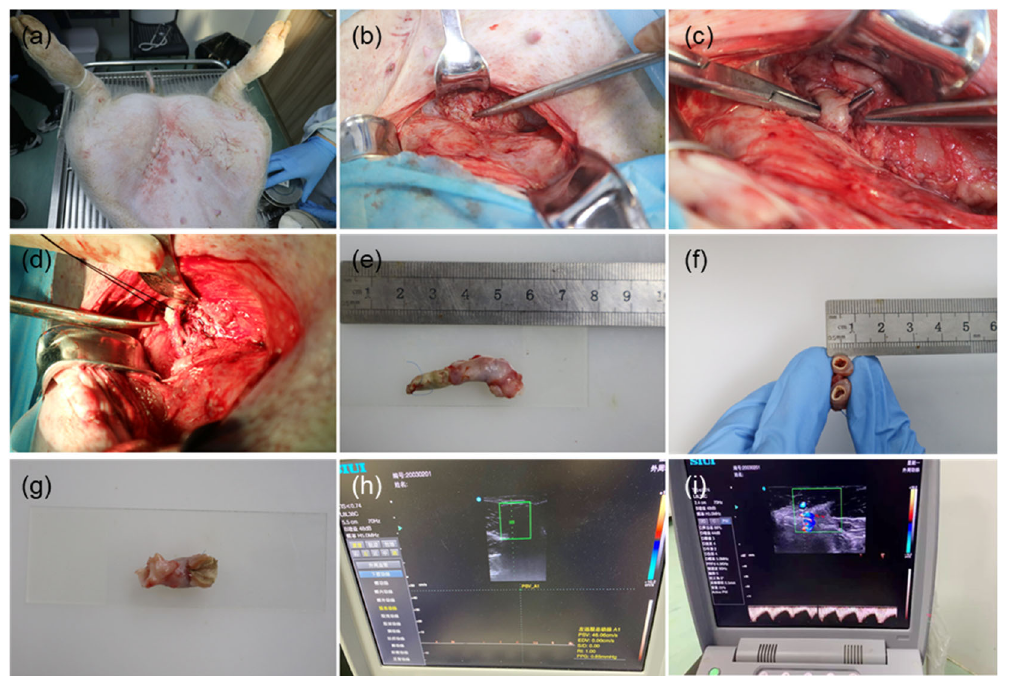
Fig. 12 Removal of the bioarti fi cial blood vessel: a Anesthetizing the pig to expose the surgical scar. b Peeling the tissue layer by layer. c Exposing the implanted bioarti fi cial blood vessel. d Cutting the bioarti fi cial blood vessel at both ends of the suture. e Removing the